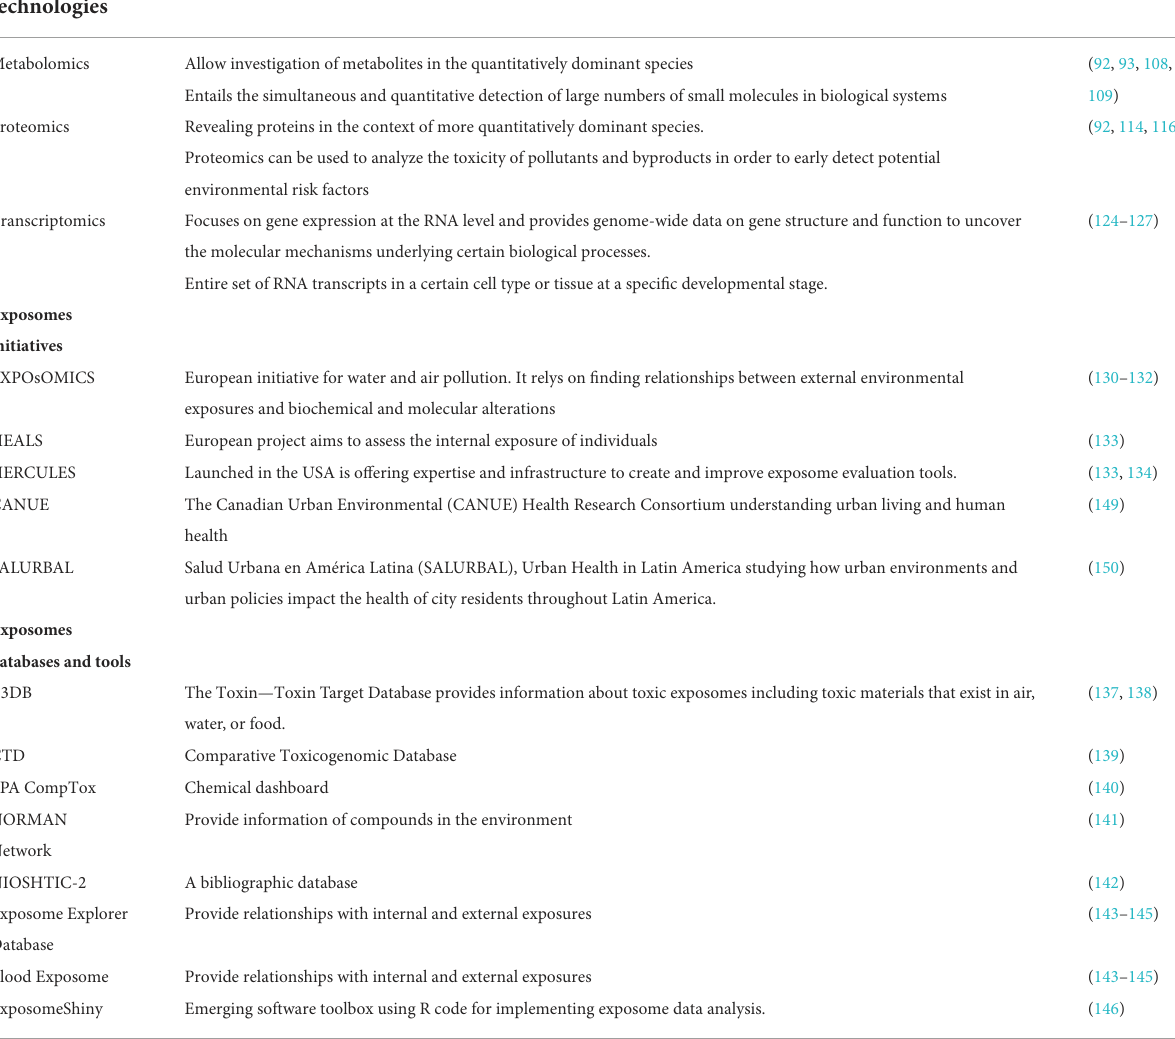
TABLE 2 Omic technologies and study designs for the monitoring of climate change induced environmental